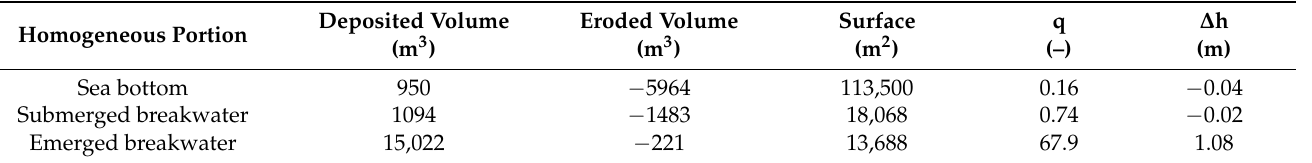
Table 1. Deposited and removed volumes between DSMs 1 and 2, surface extensions, ratios (q) between deposited and removed volumes, and average height variations ( ∆ h) for the three homogeneous portions. Deposited Homogeneous Portion